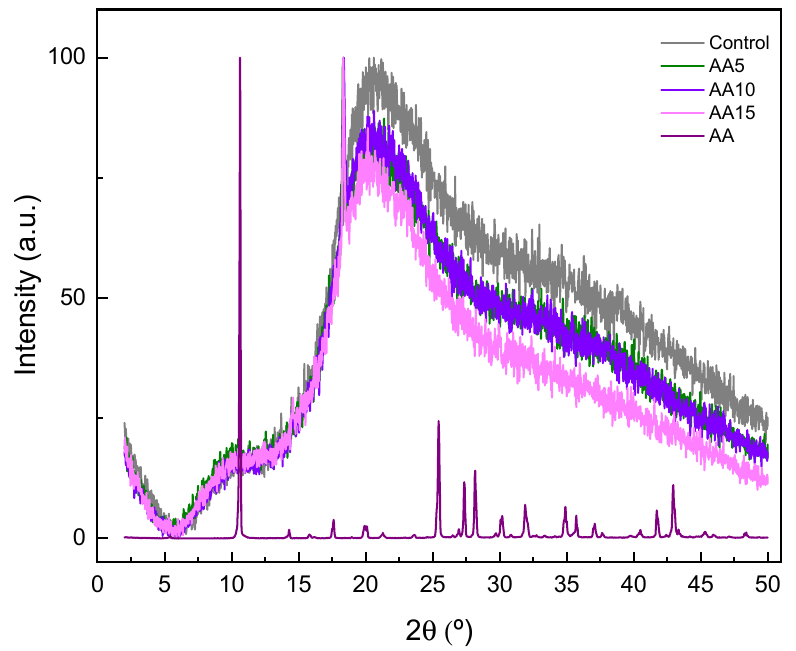
Figure 7. XRD patterns for ascorbic acid (AA) and WPI films as a function of AA content.